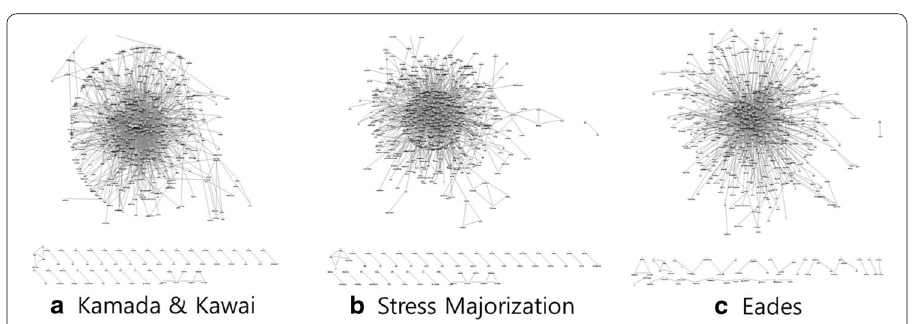
Fig. 3 Layout after deselecting isolated nodes (Kamada & Kawai vs. Stress Majorization vs.